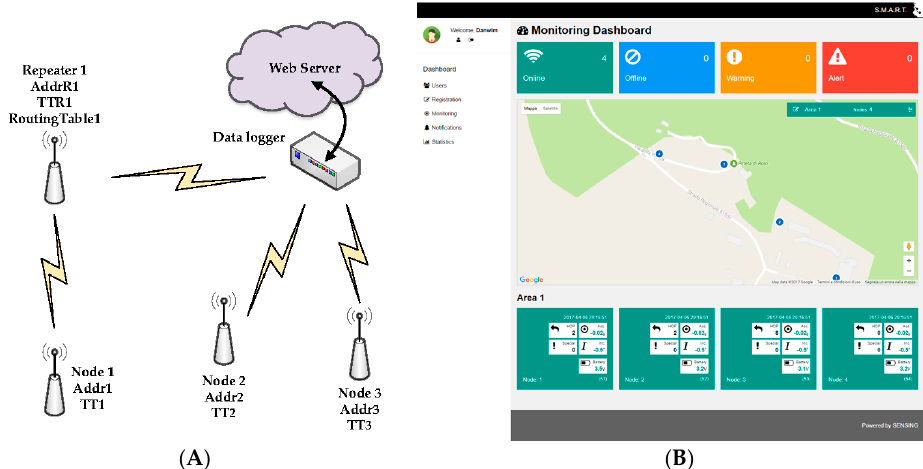
Figure 3. ( A ) Installation scenario; ( B ) graphical web interfaces: monitoring control